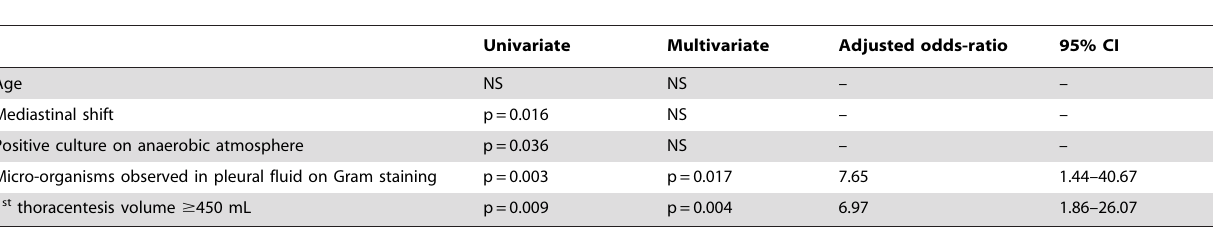
Table 5. Factors associated with outcome of iterative therapeutic thoracentesis.